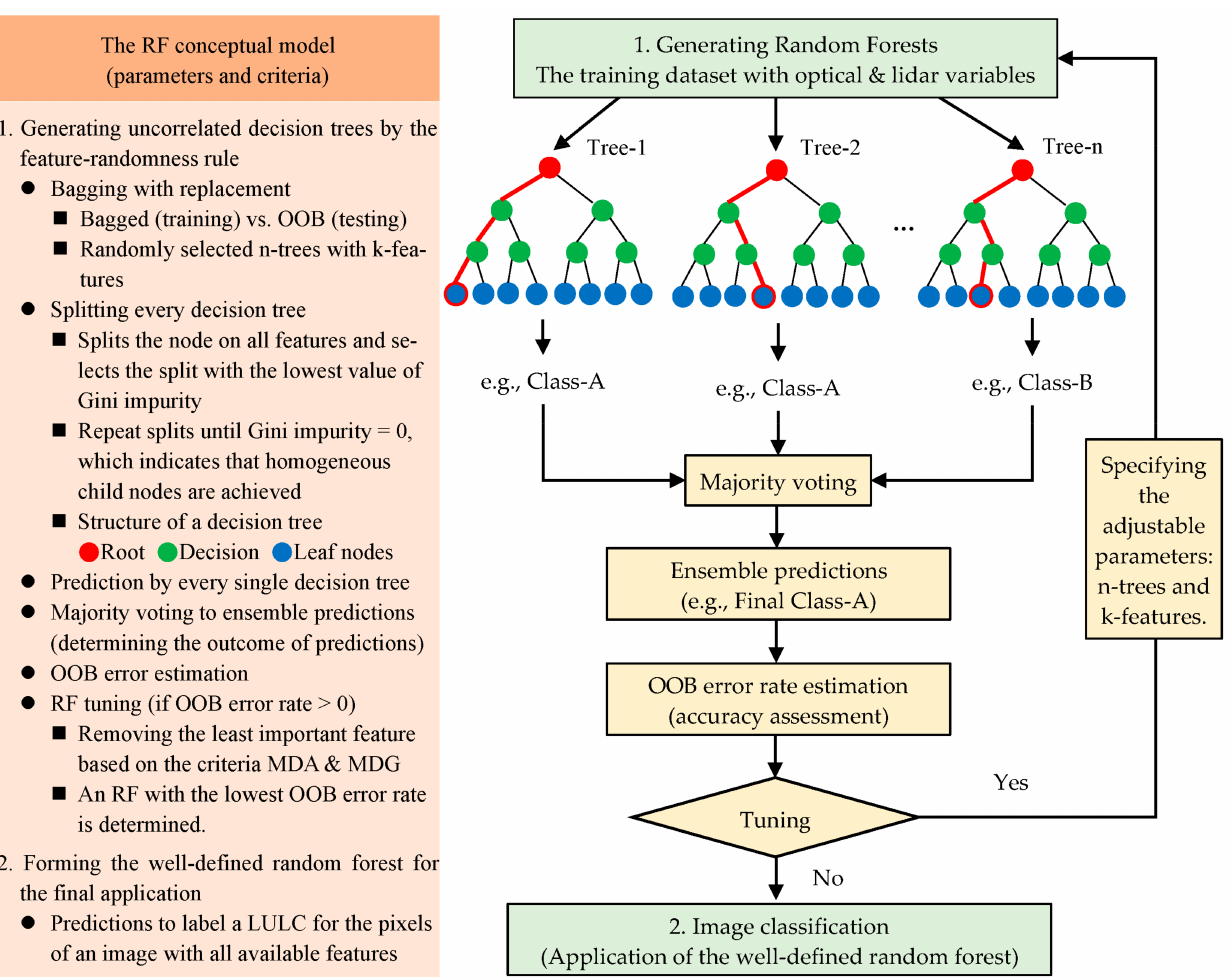
Figure 3. The processes of the random forest classifier in generating independent decision trees for LULC mapping. The highlighted red path from the root node through the decision node to the leaf node demonstrates the prediction of that decision tree. The final result is the ensemble predictions based on the majority of the prediction made by all the trees in the random